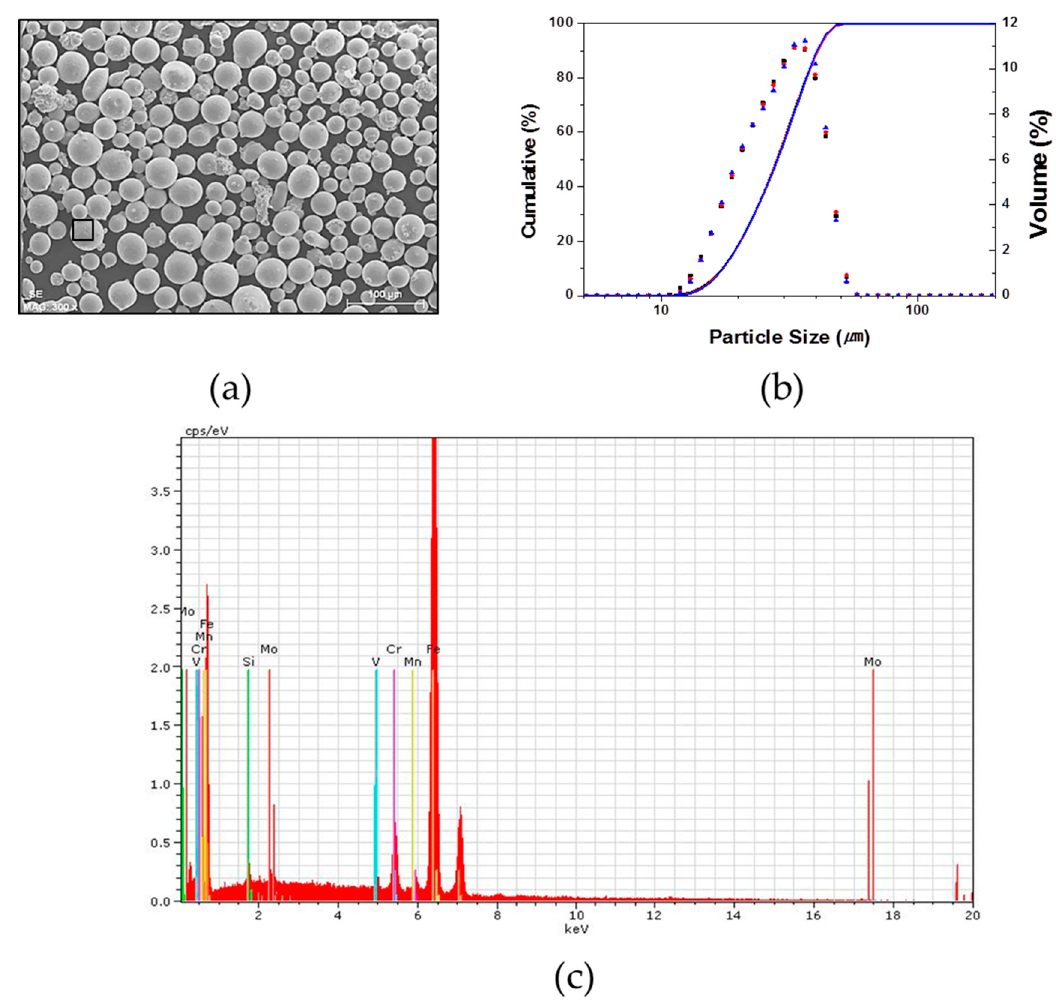
Figure 1. ( a ) SEM picture of the powder input; ( b ) particle size distribution; and ( c ) EDS result at the location indicated by the rectangle in ( a ).